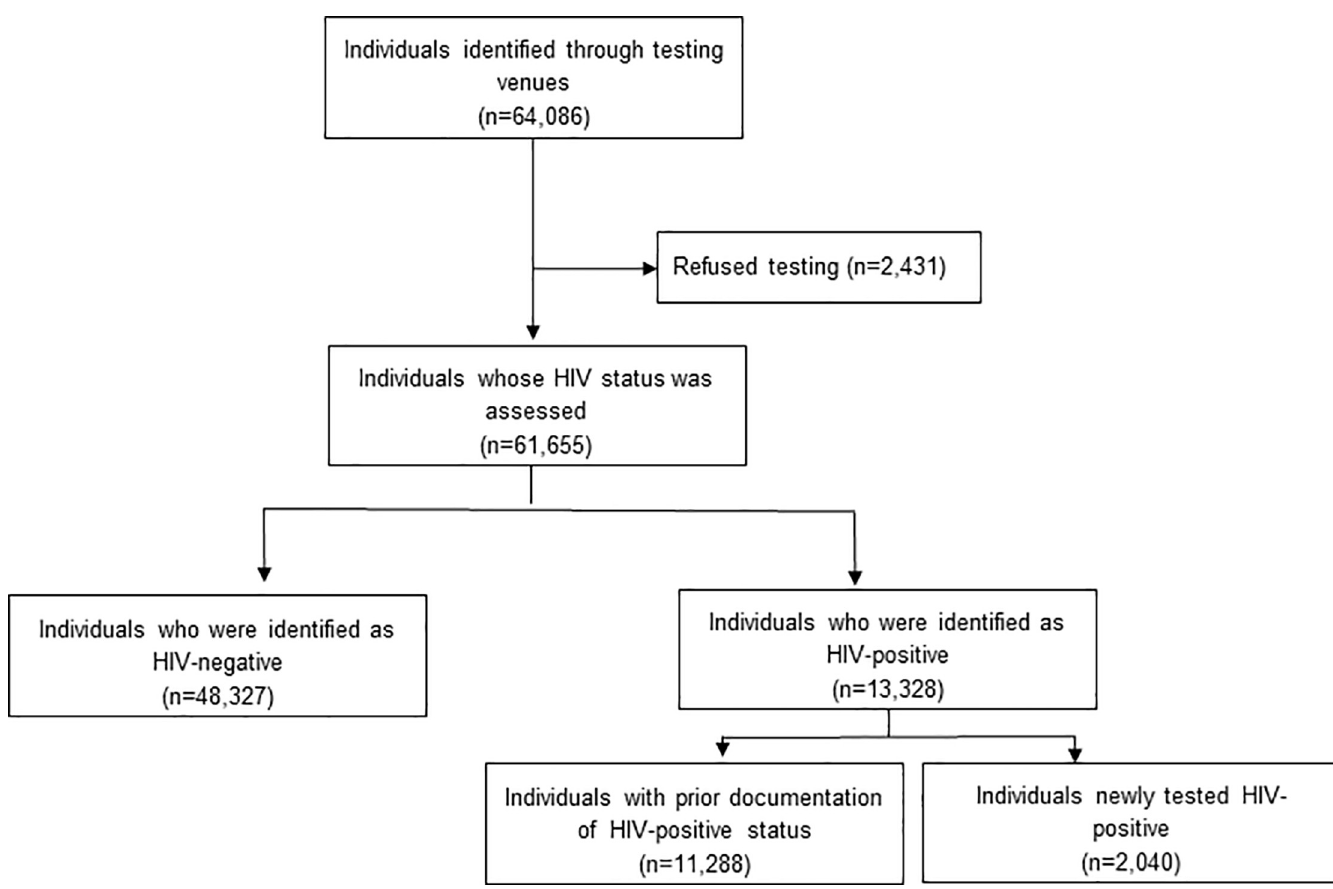
Fig 1. Consort diagram of the assessment of HIV status among participants identified in the Botswana Combination Prevention